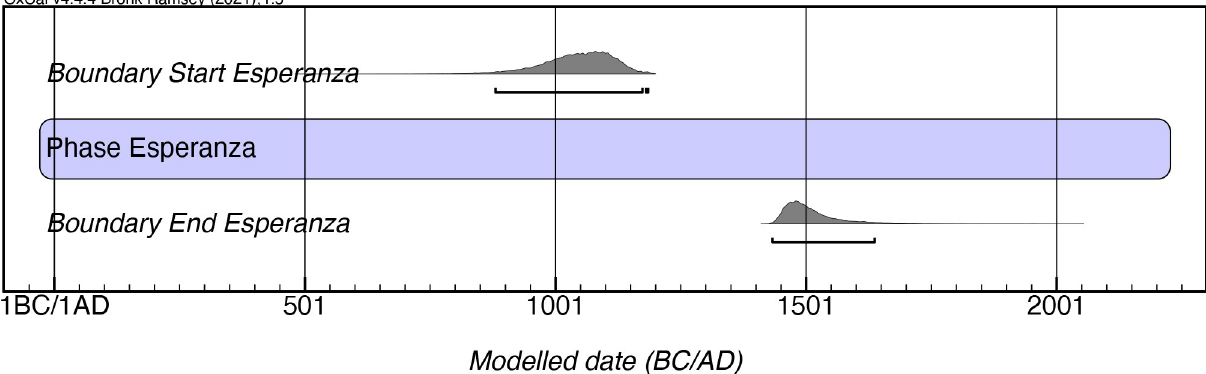
Fig 16. Modeled date ranges for the Esperanza style in Puerto Rico. Probability distributions indicate modeled 2 σ (95.4%) confidence intervals for beginning and end of phase.